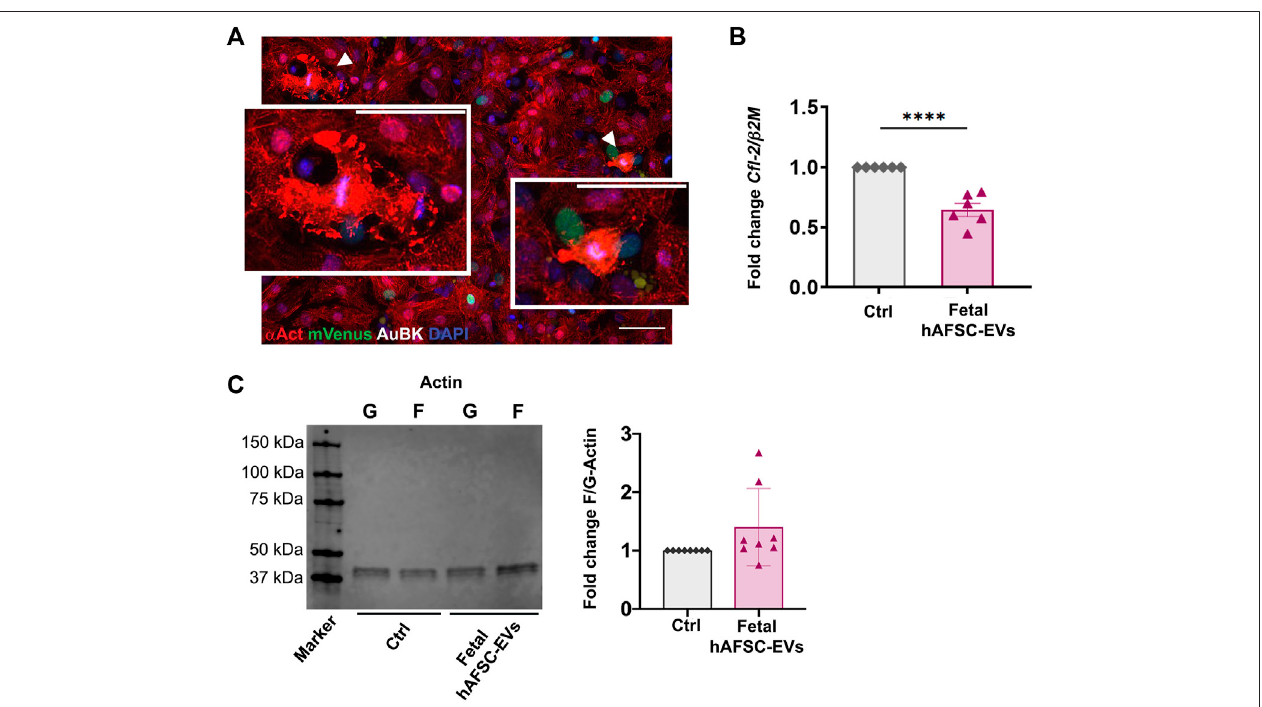
FIGURE 3 | Analysis of actin cytoskeleton regulation in mNVCM following fetal hAFSC-EV stimulation (A) Representative immunostaining pictures of mNVCM with sign of sarcomeric disassembly following fetal hAFSC-EV treatment as seen in Figure 1A ; white arrows indicate mNVCM with disarranged expression of sarcomeric α - actinin ( α Act, red) and intense Aurora B kinase signal (AuBK, white) associated to the chromosomal material (DAPI, blue), scale bar: 50 and 25 µm in the inlet. (B) Real- timeqRT-PCRanalysisofmNVCMstimulatedbyfetalhAFSC-EVsovervehicle-treatedcontrolcells(Ctrl)for Co fi lin-2(C fl -2) geneexpressionasnormalized toBeta 2 Microglobulin ( β 2M), as housekeeping reference. All values are expressed as mean ± s.e.m of CFL-2/ β 2M fold change for n = 6 independent experiments with Ctrl group as calibrator (Ctrl: 1; fetal hAFSC-EVs: 0.64 ± 0.13; **** p < 0.001). (C) Left panel: representative image of Western Blot analysis of G-Actin (G) and F-Actin (F) expression in mNVCM treated with fetal hAFSC-EVs (fetal hAFSC-EVs) over vehicle solution control (Ctrl); right panel: evaluation of F-Actin/G-Actin in mNVCM treated with fetal hAFSC-EVs over vehicle solution control. All values are expressed as mean ± s.e.m of fold change of F-Actin/G-Actin ratio (Fold Change F/G-Actin) of n = 8 independent experiments by densitometry on protein band intensity with Ctrl group as calibrator (Ctrl: 1; fetal hAFSC-EVs: 1.40 ± 0.23). kDa: kilo Dalton .